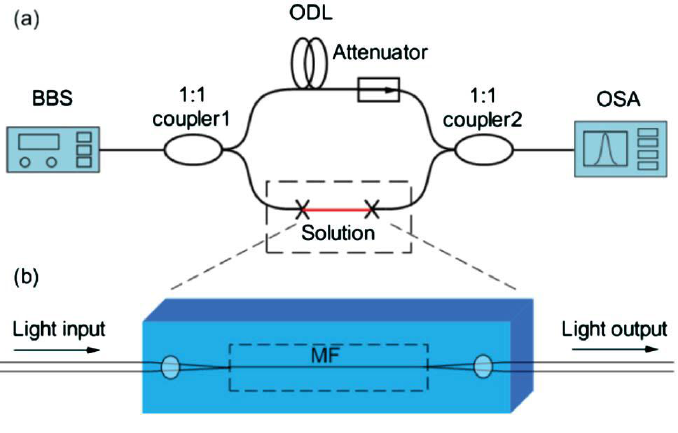
Figure 15. ( a ) Schematic configuration of the MZI-based RI sensor; ( b ) Schematic diagram of the sensing arm. BBS, broadband light source; ODL, optical delay line; OSA, optical spectrum analyzer; MF, microfiber